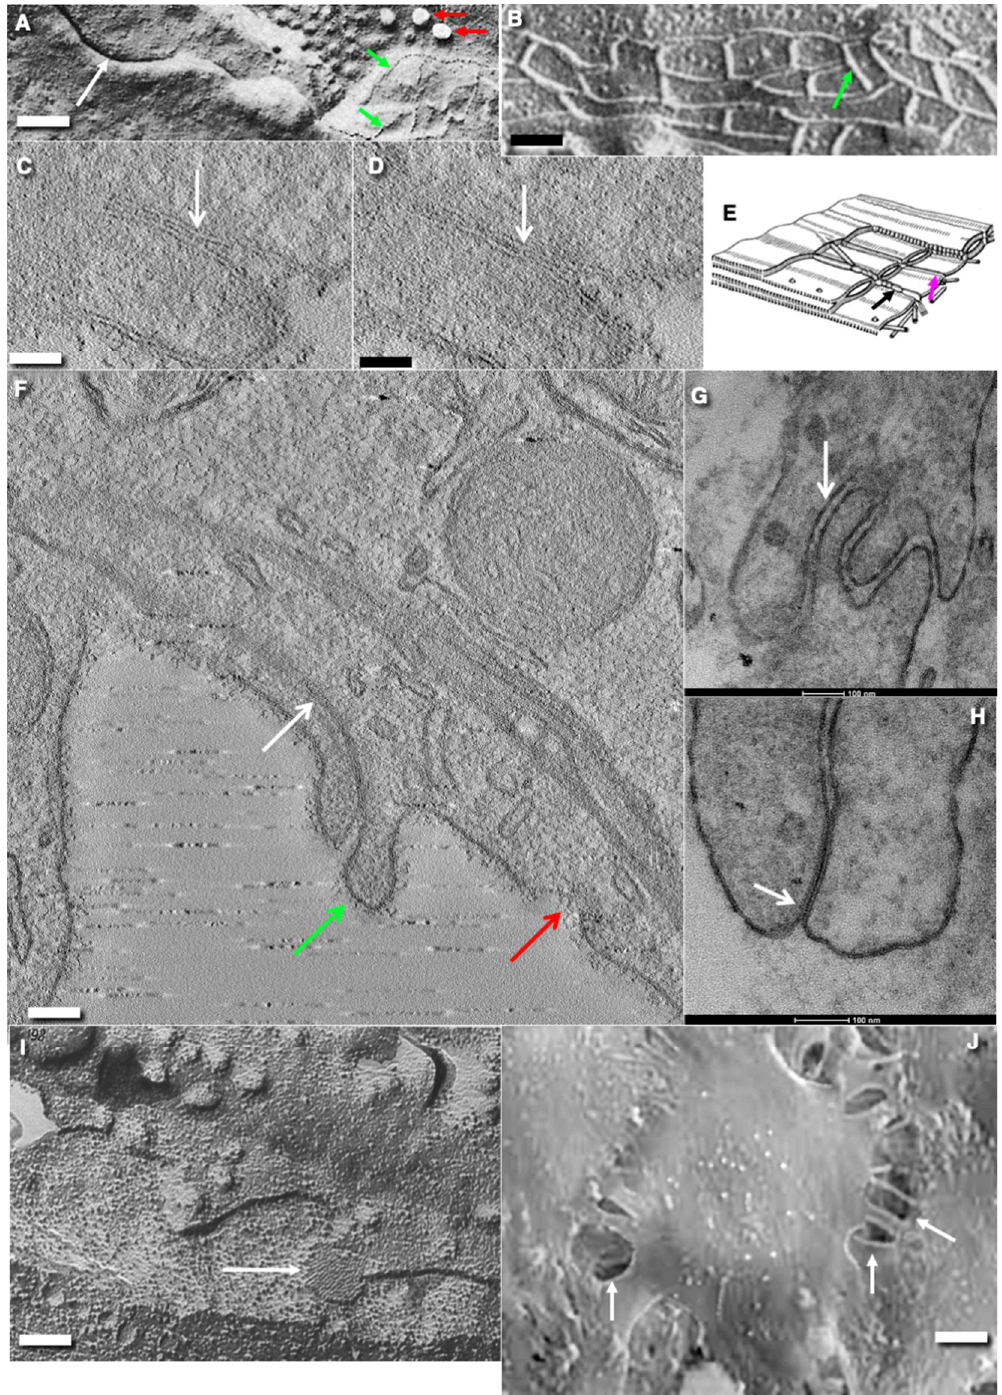
Figure 5. Structure of the EC contacts and junctions in rats and mice. ( A ) ECs of blood capillary in derma. Platinum replicas obtained after tangential freeze-fracture of the EC near the inter-endothelial contact. Green arrow indicates the fracture of tight junction. Red arrow demonstrates the fracture of caveolae. ( B ) The freeze-fracture of the typical TJ between ECs of blood brain capillary. Green arrows indicate the locking fibril of TJ. ( C , D ) Serial virtual tomography electron microscopic slices. White arrows show the locking fibrils of TJ which appears as a white dot connecting two membranes of opposite ECs. ( E ) Scheme of TJ. On the freeze-fracture, of the contact zone of ECs, locking fibrils consisting of intramembrane particles appear as widely anastomosing and fence-like elevations (ridges; black arrow)) or depressions (grooves; magenta arrow). ( F ) The tile-like contact between ECs. It is supplemented with TJ (white arrow). The green arrow indicates the near-contact cytoplasmic protrusions between ECs of blood capillary in brain. Red arrow shows clathrin-coated pit on